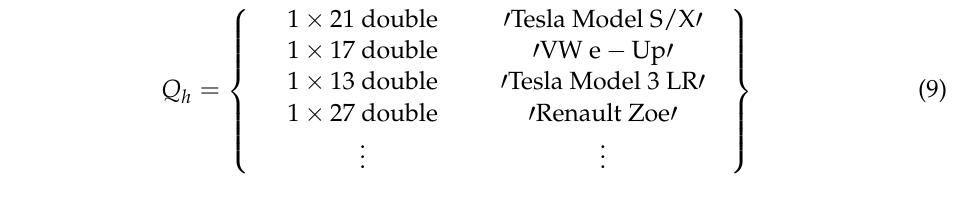
Algorithm 2 returns Q h a structure composed of two columns and H EV lines, which